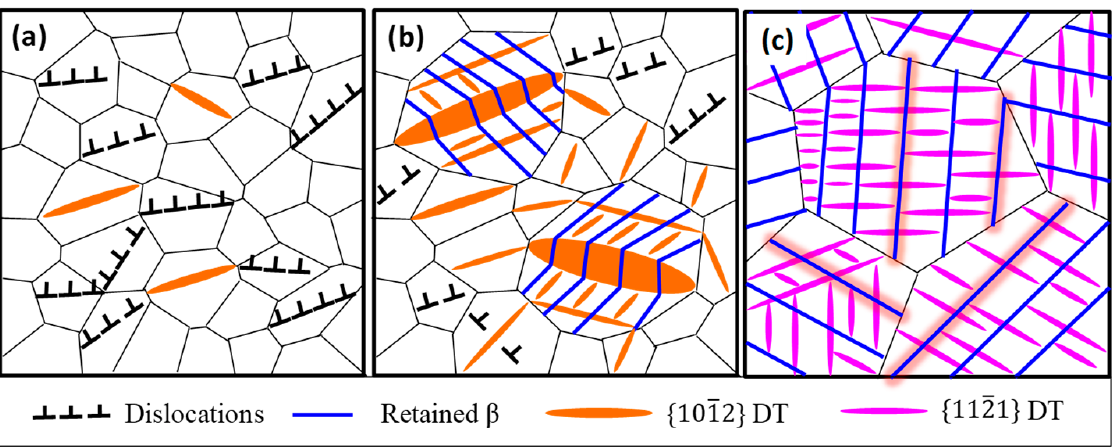
Figure 8. Schematic diagram of deformation modes of the different grain size characteristic TA3 alloy during impact deformation: ( a ) FG Ti, ( b ) MG Ti, and ( c ) CG Ti sample. As the interface between the α matrix and the retained β is not atomically flat, and comprised of a series of facets, DTs would preferentially nucleated at the α / β interface [33]. Thus, the high density of α / β interface in CG Ti provides sufficient DTs nucleation sites, resulting in the density of activated DTs in CG Ti is obviously larger than that in MG